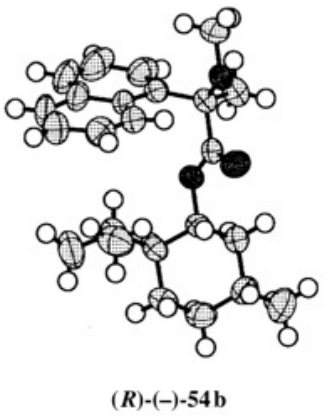
Figure 38. X-ray ORTEP drawing of menthol M α NP ester ( R )-( − )- 54b . Reprinted with permission from [56].